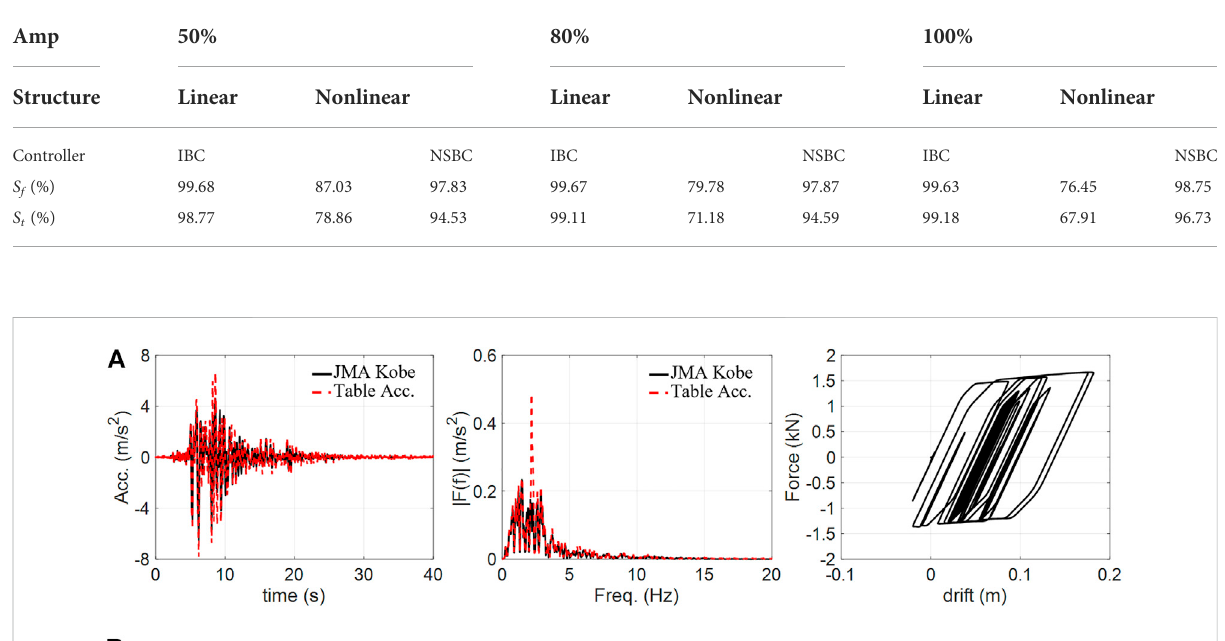
Frontiers in Built